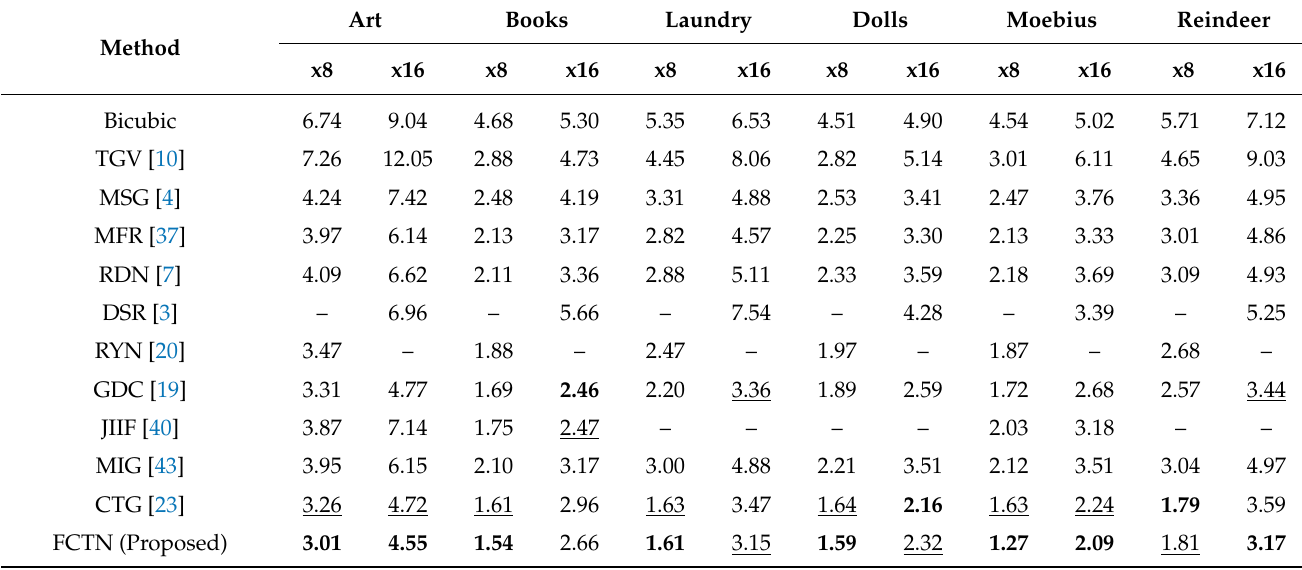
Table 2. An analysis of RMSE values for different scaling factors on the noisy Middlebury dataset. Boldface indicates the best RMSE for each evaluation, while the underline indicates the second